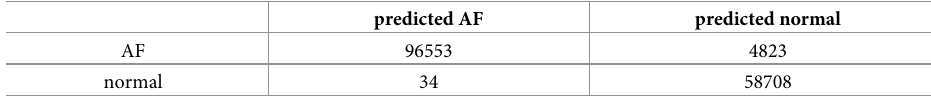
Table 3. Confusion matrix of independent dataset